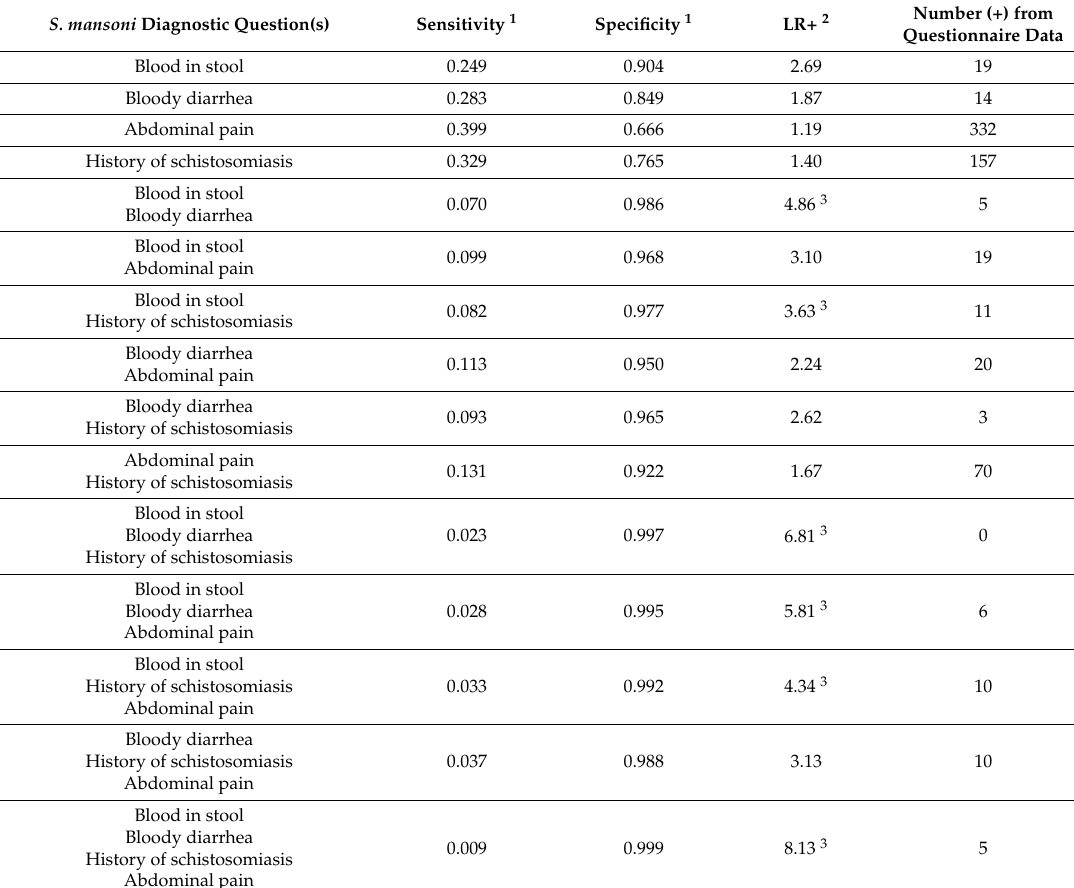
Table 2. Diagnostic performance of each question and combination of questions for correctly classifying an individual as S. mansoni